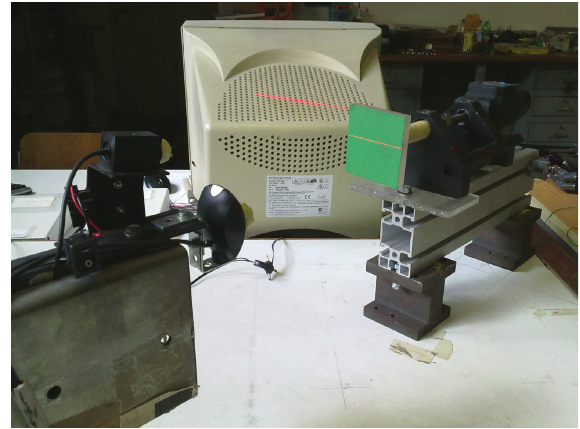
Figure 2: Calibration procedure of robot-laser scanner